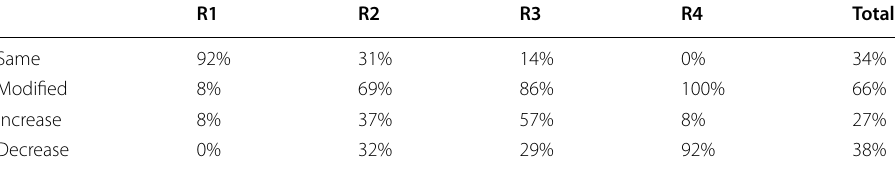
Table 11 Comparison of the initial self-assessment and modified initial